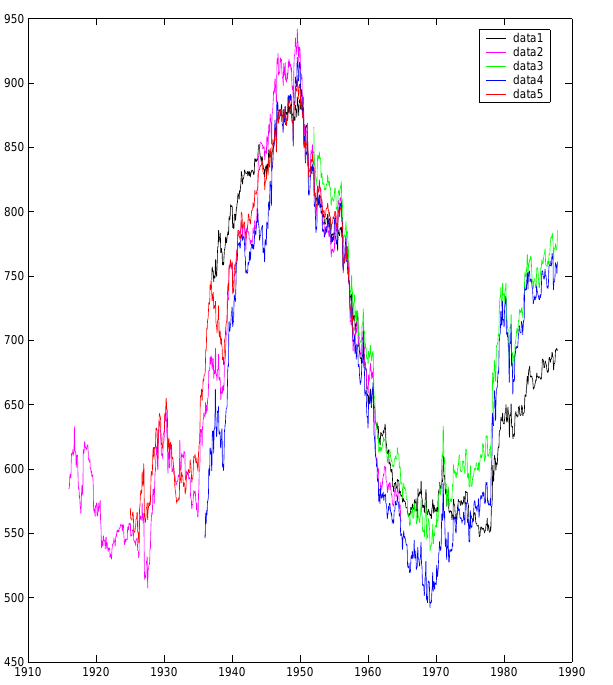
Fig. 4. Amplitude of the 6-months line, A 6 (t) , for (1) CLF (2) HAD (3) ESK (4) LER (5) SIT. X component. Vertical unit: .35 10 − 3